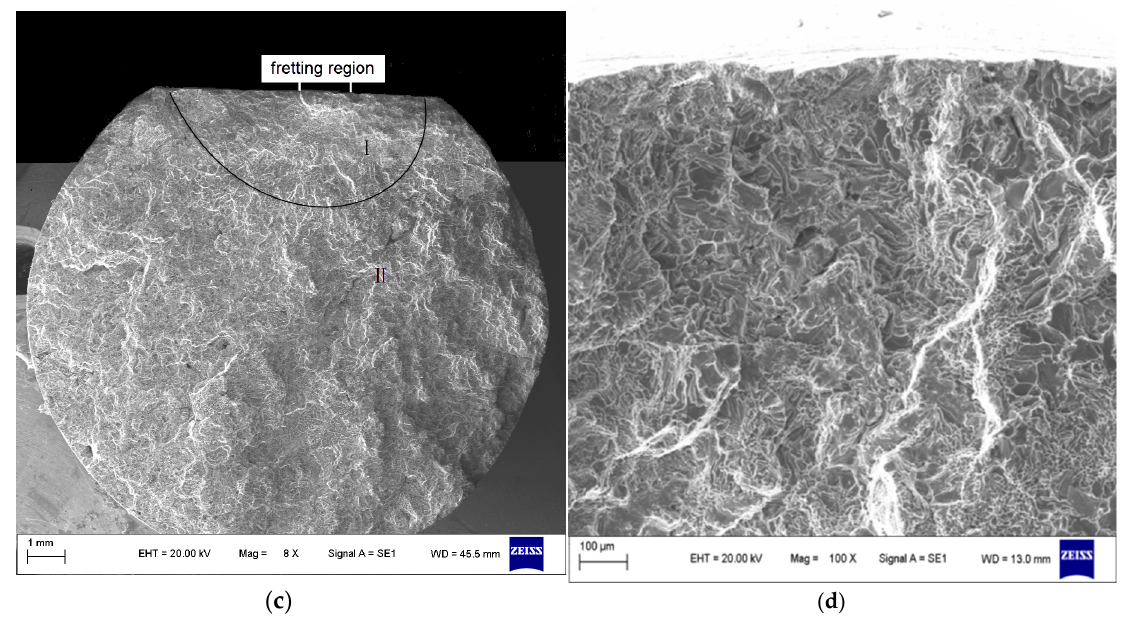
Figure 6. SEM micrographs of the fracture of AlSi9Cu2Mg. ( a , b ) Plain fatigue test specimen ( N p = 8.4 × 10 5 ); and ( c , d ) fretting fatigue test specimen ( N f = 2.8 × 10 5 , σ n = 62.5 MPa).